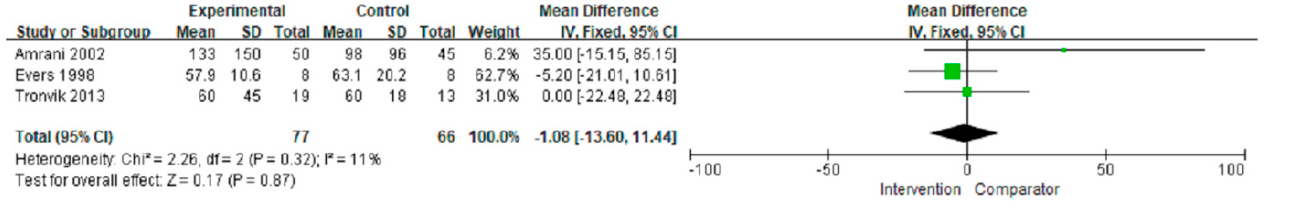
Figure 6. The effect of pharmacological treatment for duration of attacks compared to placebo. Green squares indicated effect size for each of included studies and the size of green square indicates the weight assigned to that study in the meta-analysis. Black diamond suggested as meta-analyzed measure of effect. Bold letters represented a category or subtotal of overall outcome.